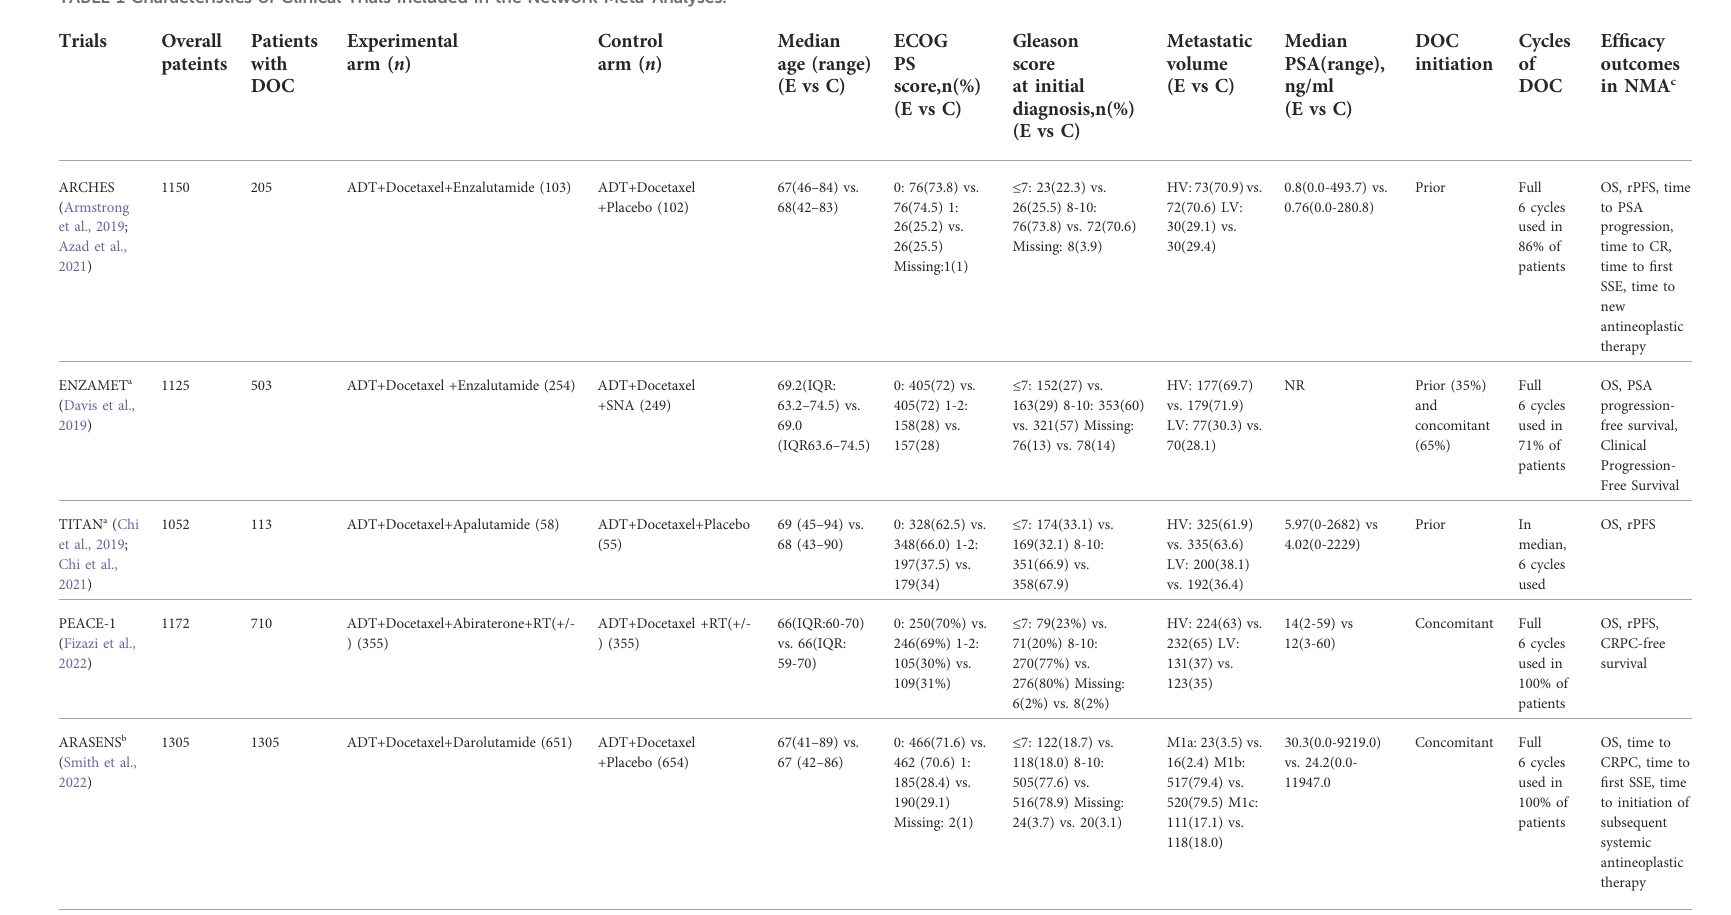
TABLE 1 Characteristics of Clinical Trials Included in the Network Meta-Analyses.